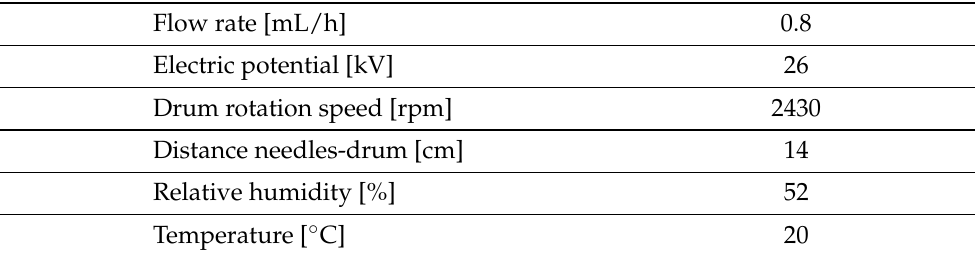
Table 2. Electrospinning parameters used for the production of the P(VDF-TrFE-CTFE) nanofiber